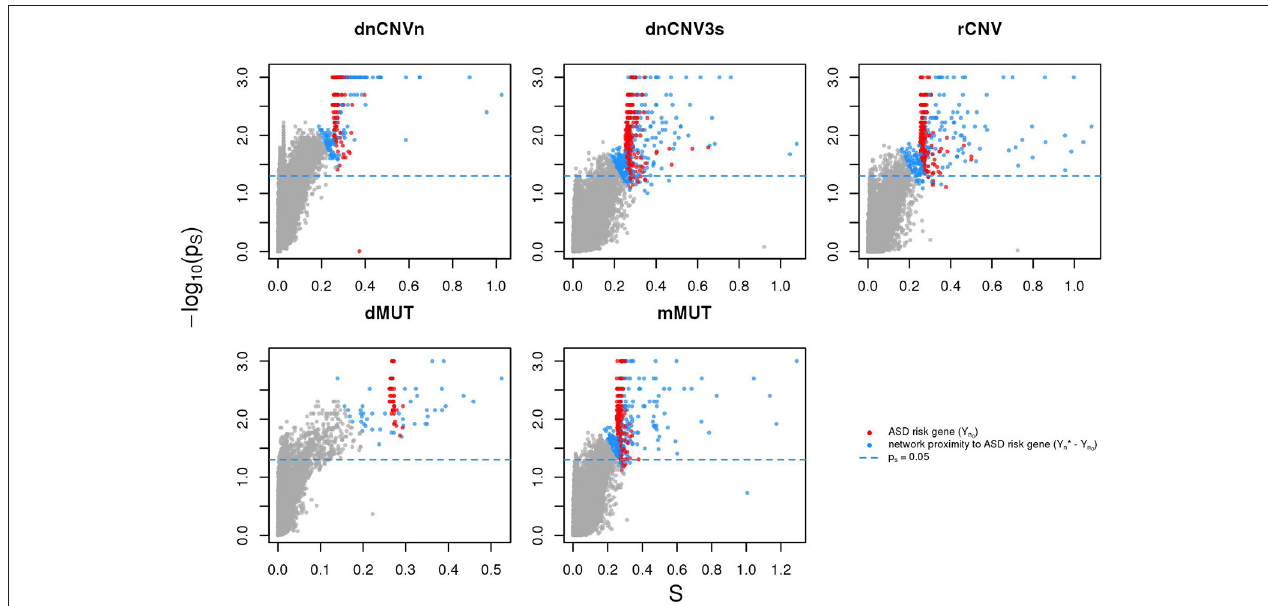
FIGURE 3 | Genes in network proximity to ASD risk genes. The network smoothing index ( S ) and the corresponding p value ( p s ) are the two factors that make up Sp . Blue: genes belonging to the corresponding original list (sources); red: genes in network proximity to sources; gray: remaining genes.